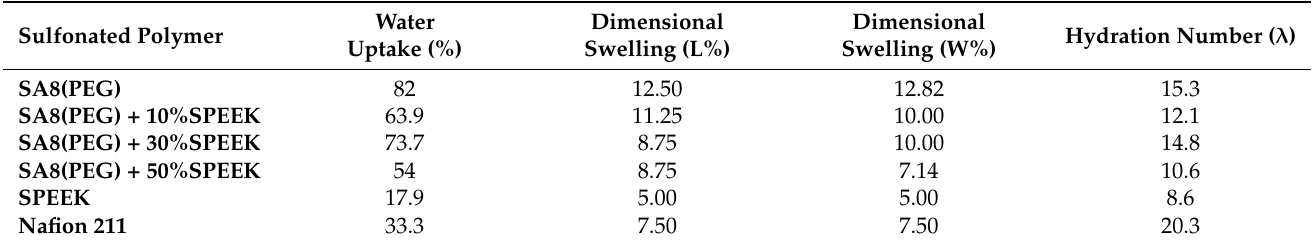
Table 8. The physicochemical parameter characteristics of SA8 blended with PEG and sPEEK.